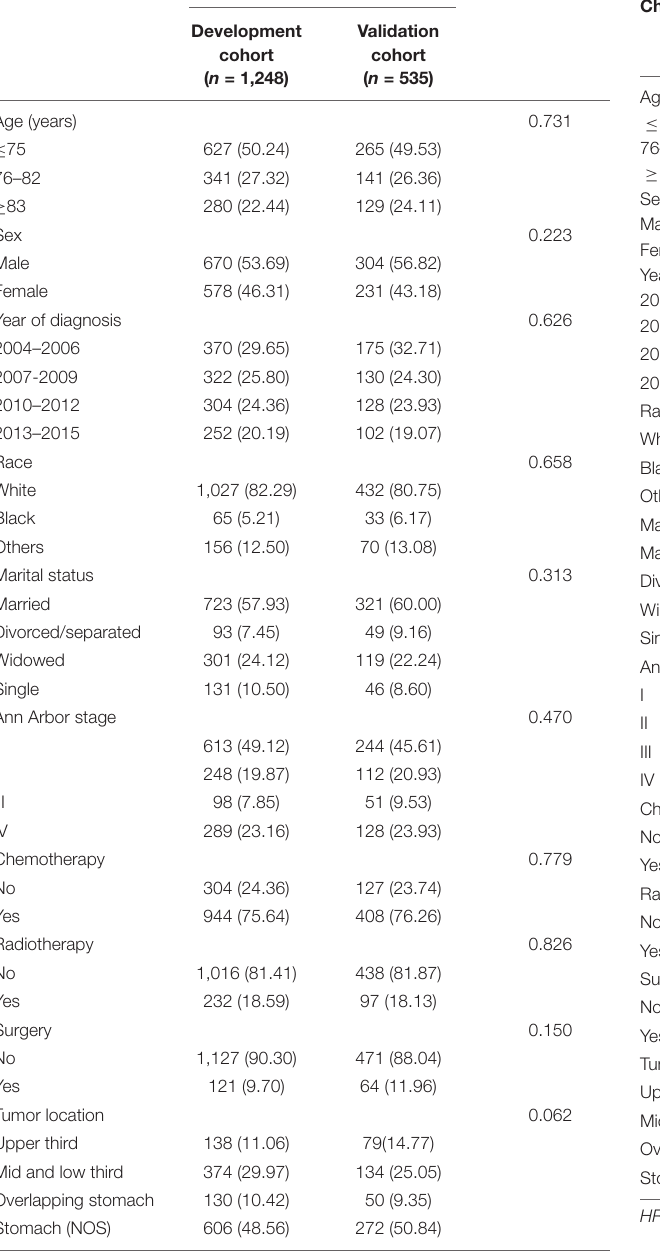
TABLE 1 | Patient characteristics and clinicopathological variables. TABLE 2 | Results of the univariate and multivariate cox models, including the nomogram variables for overall survival in the development cohort. Characteristic Univariate analysis Multivariate